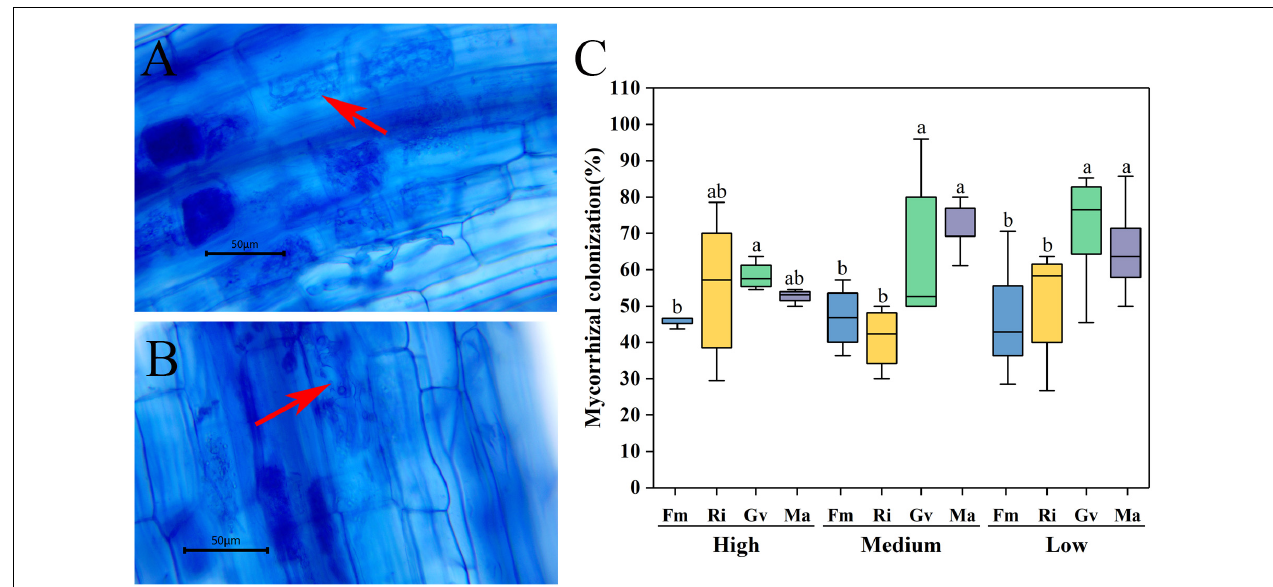
FIGURE 1 | Mycorrhizal infection of cherry tomato root inoculated with arbuscular mycorrhizal fungi (AMF) at different nutrient levels. (A,B) Arbuscular structure of root (arrow); (C) Mycorrhizal colonization of cherry tomato under different nutrient levels. Different letters indicate that there were significant differences among different AMF inoculation treatments at the same nutrient level ( P < 0.05), the same as below.